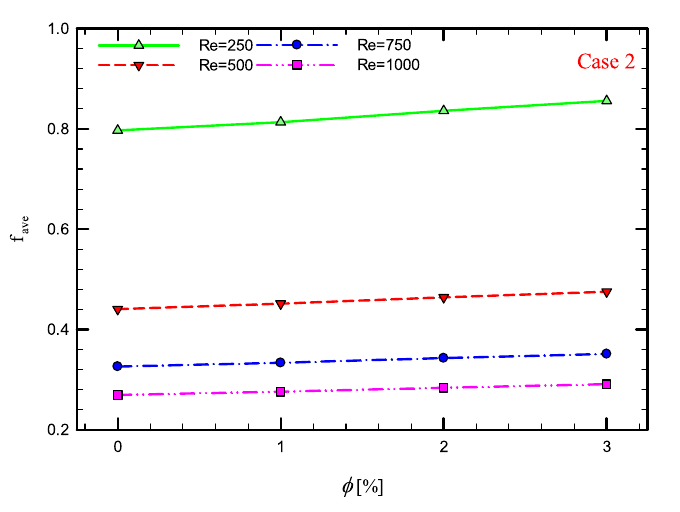
Figure 42. f ave versus φ for Case 2.